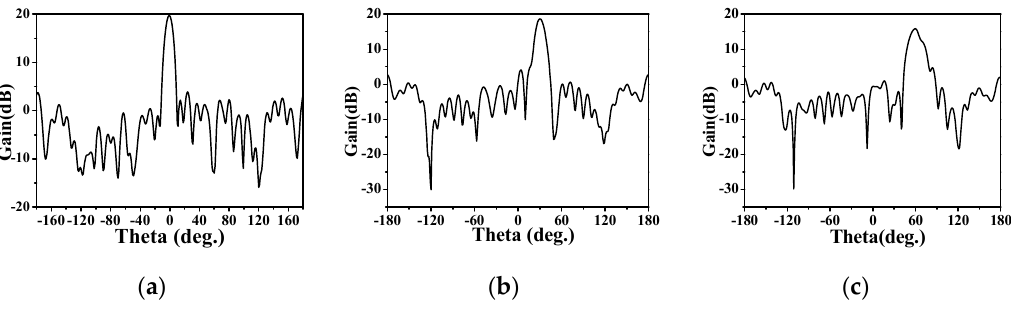
Figure 6. Radiation patterns of the proposed 1-bit digital RRM at ( a ) θ r = 0 ◦ ; ( b ) θ r = 30 ◦ ; ( c ) θ r = 60 ◦ ° .